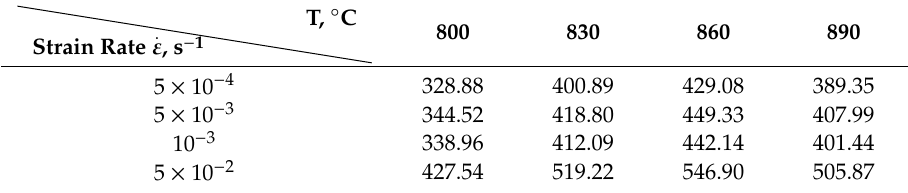
Table 2. Activation energy Q ( ± 7.7) during superplastic deformation of the TC4 alloy. . ε Strain Rate , s − 1